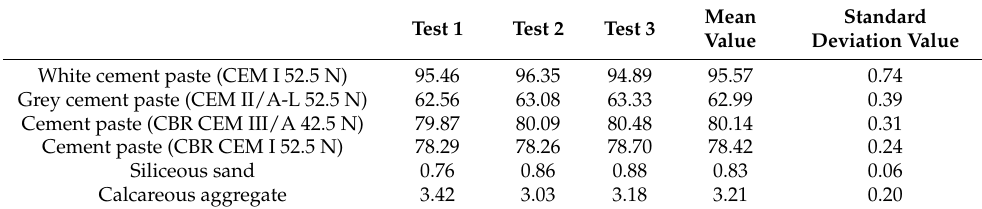
Table 4. Experimental results of SFSA for cement pastes and natural aggregates (%).